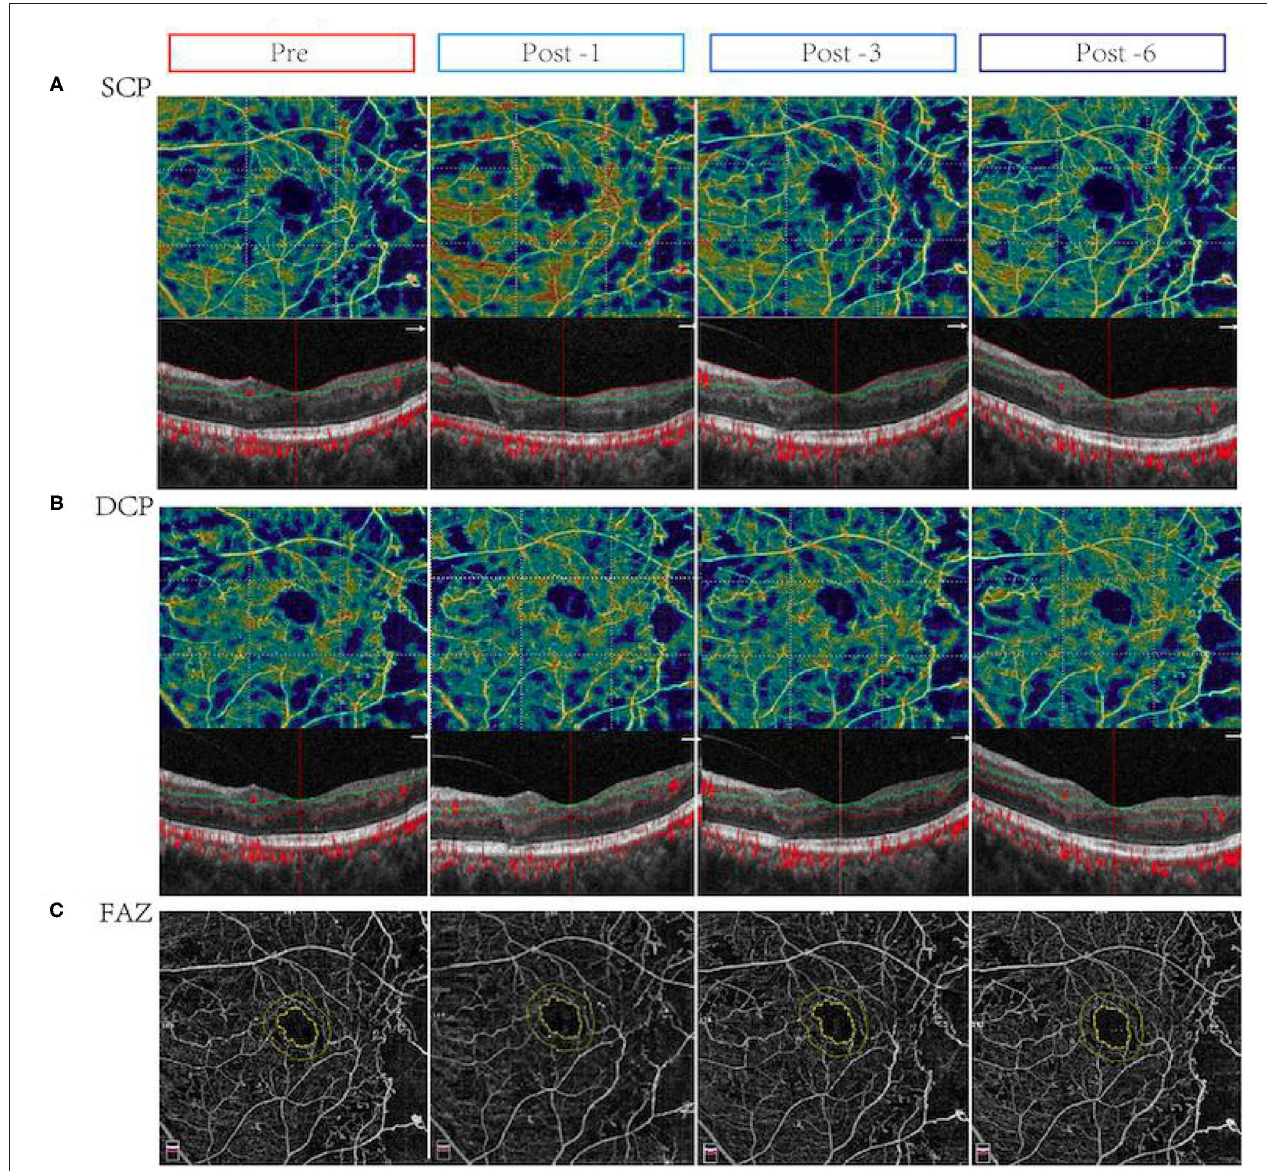
FIGURE 2 | Changes in vessel density (VD) and flow area in eyes with non-center involved DME (NCI-DME) before and after intravitreal conbercept injection. Pre: before treatment; Post -1, 1 month after treatment; Post -3, 3 months after treatment; Post -6, 6 months after treatment. (A) The vessel density in the superficial capillary plexus (SCP) before and after treatment for 1, 3, and 6 months with NCI-DME patients: after treatment, the microvascular density in the inferior area of SCP improved. (B) The vessel density in the deep capillary plexus (DCP) in patients with NCI-DME before and after treatment for 1, 3, and 6 months: after treatment, the microvascular density in the central fovea area of DCP improved. (C) The FAZ in patients with NCI-DME before and after conbercept intravitreal injection: there was no significant difference before and after treatment.